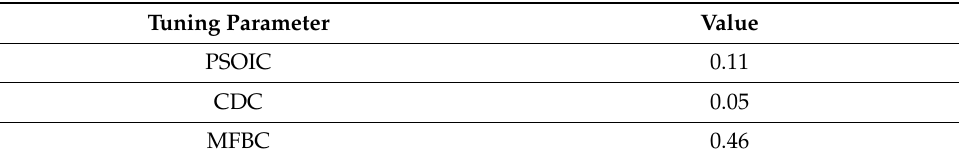
Table 4. Combustion model calibration parameters: optimized values. Tuning